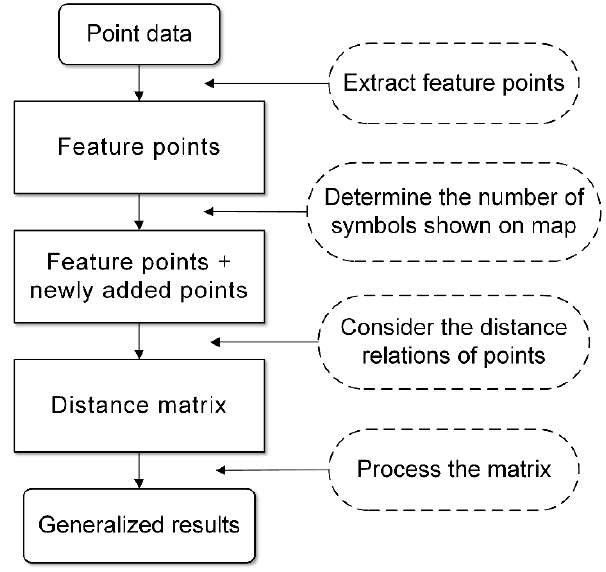
Figure 2. The main workflow of the idea.